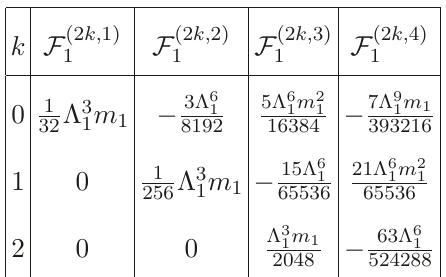
Table 1 . The coefficients of the prepotential for the N f = 1